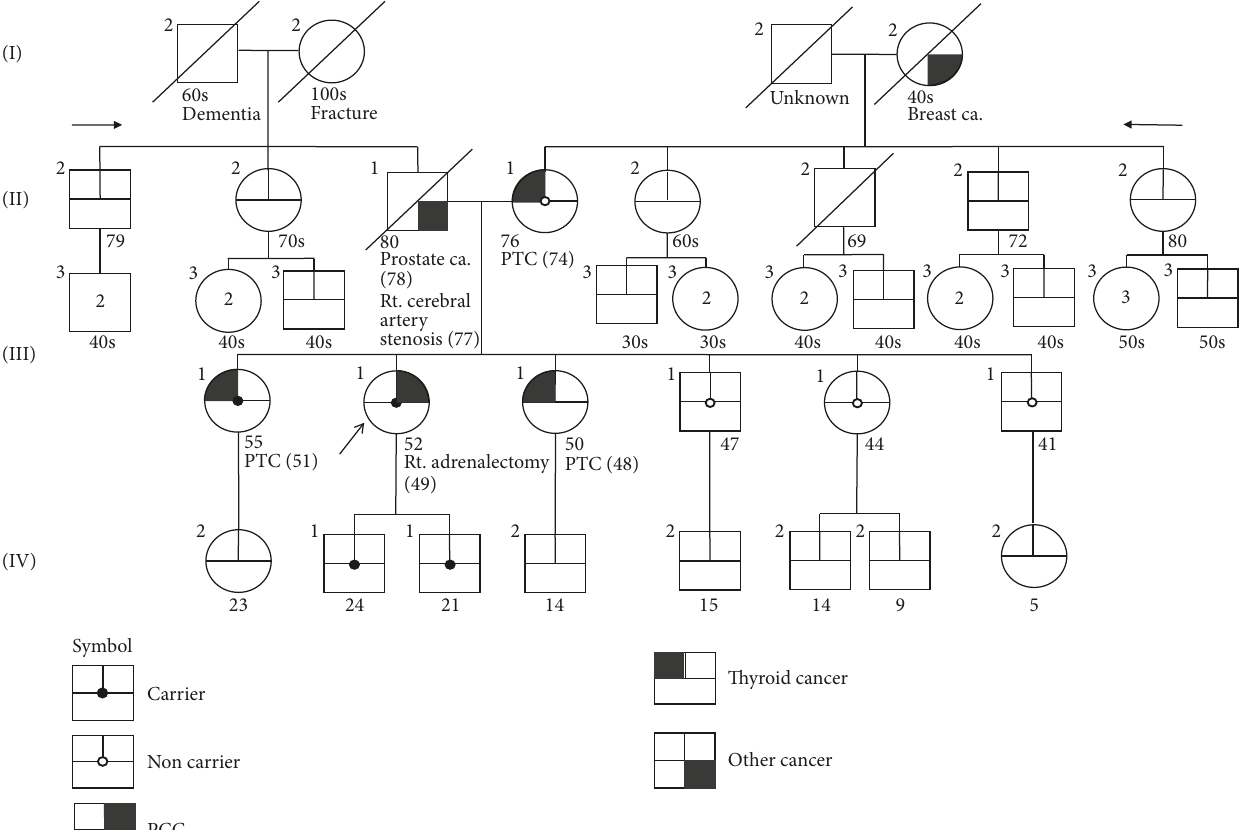
Figure 2: Pedigree of the index patient (arrow) and her family. The RET D898Y germline mutation was detected in the index patient, her two sons, and her older